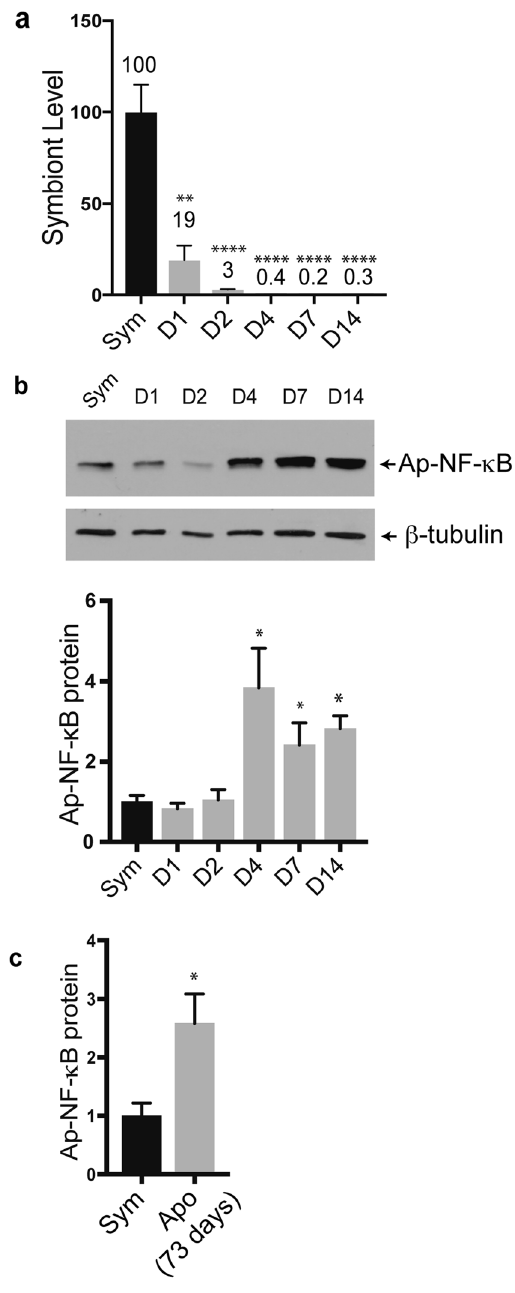
Figure 4. Increased expression of NF- κ B protein following loss of symbiosis. ( a ) qPCR of Symbiodinium Clade B 28 S rRNA was performed on RNA from anemones collected at the indicated time-points during or after menthol treatment. Anemones were incubated with menthol on D1-D3 and were placed in fresh ASW from D4-D14. Symbiodinium 28 S rRNA levels are relative to the amount of 28 S rRNA in symbiotic animals (100). Sym n = 6, all other groups n = 3. Statistical significance for each group compared to symbiotic was determined using an unpaired T-test: ** p < 0.01, **** p < 0.0001. ( b ) Representative anti-Ap-NF- κ B Western blot of extracts from symbiotic and menthol-treated Aiptasia extracts prepared from animals treated as in ( a ). Shown is the portion of the gel containing the processed form of Ap-NF- κ B. At this exposure, the much weaker full-length form of Ap-NF- κ B was not seen (e.g., see Fig. 2f). The filter was then stripped and reprobed for β -tubulin. Quantitation (bottom) is based on the relative amount of Ap-NF- κ B protein from band quantitation using ImageJ of all biological replicates for each group. In each case, Ap-NF- κ B values normalized to the amount of β -tubulin in each sample, and values are relative to the amount of NF- κ B in the Sym animals (1.0). Statistical significance was determined using an unpaired T-test for each group as compared to the symbiotic control group. * p < 0.05. ( c ) Quantitation of relative Ap-NF- κ B protein from symbiotic anemones (1.0) compared to anemones that were maintained in the aposymbiotic for 73 days. NF- κ B was quantified from Western blots as described for ( b ). Sym n = 5, Apo n = 3. Statistical significance was determined using an unpaired T-test as above: * p <